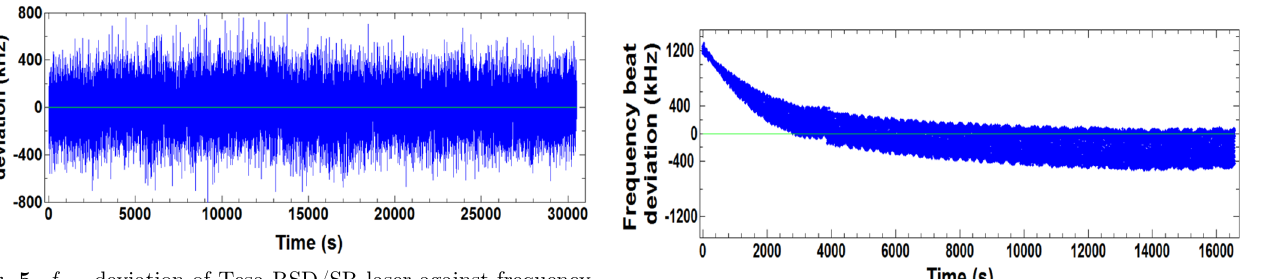
Fig. 5. f beat deviation of Tesa RSD/SR laser against frequency comb.